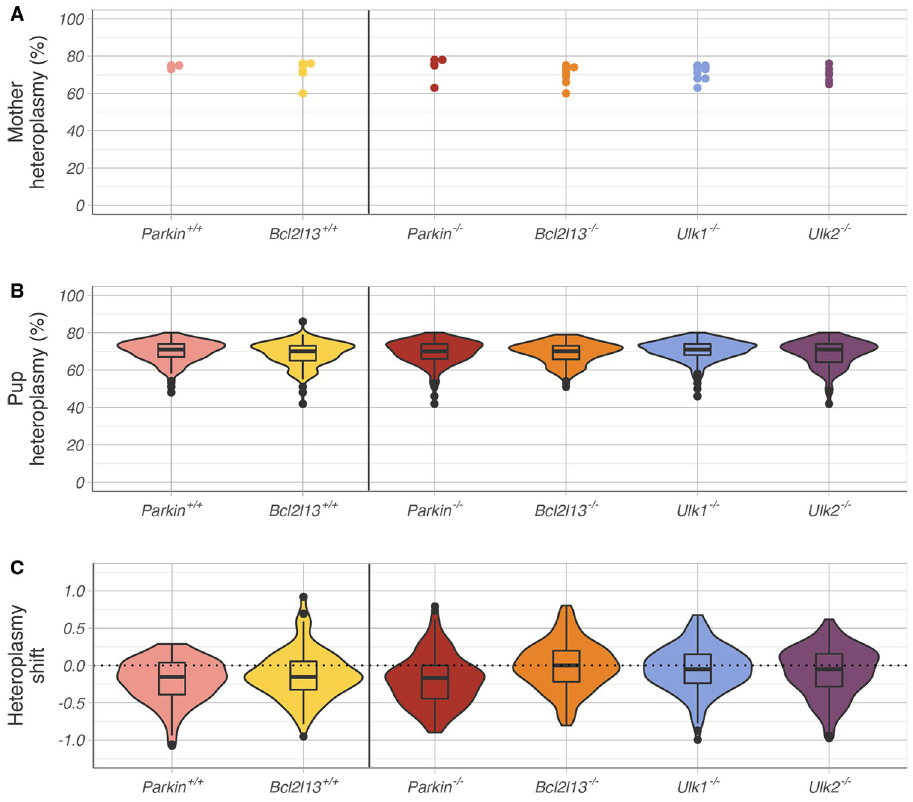
Fig 3. Mother and pup C5024T heteroplasmy across the six groups. (A) High-heteroplasmy (60–78%) mothers were selected in each group. (B) Pups within each group exhibited comparable high heteroplasmy (69.3 ± 6.3% across the cohort). (C) The mean normalised heteroplasmy shift was negative across all groups. The shift was closest to zero for the Bcl2l13 (-0.01 ± 0.32; orange) and Ulk1 (-0.04 ± 0.30; blue) knockout groups, indicating that selection may be partially disrupted by the absence of functional BCL2L13 and